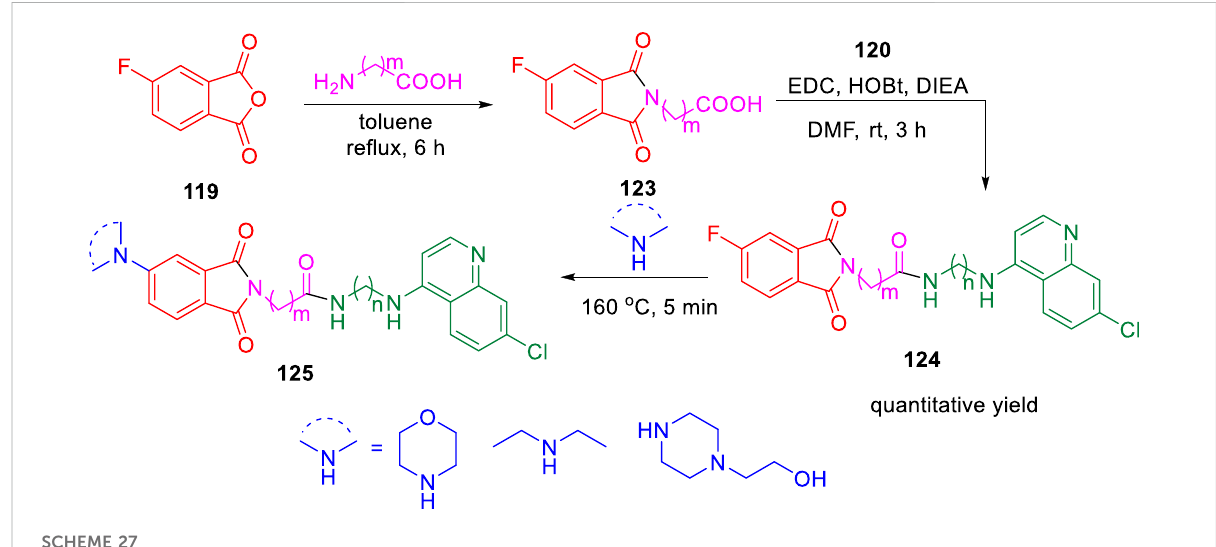
FIGURE 10 SAR study of isoindoline-1,3-dione-4-aminoquinolines.